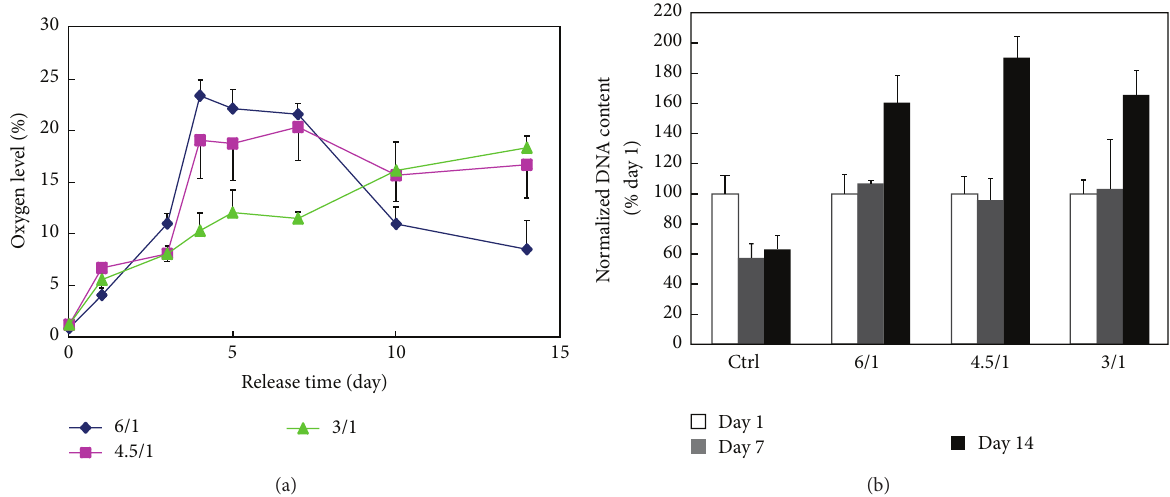
Figure 4: (a) Oxygen release kinetics of the H 2 O 2 -releasing microspheres with different H 2 O 2 /VP ratio; (b) dsDNA content of live CDCs encapsulated in hydrogels with or without oxygen release. The higher dsDNA content represents higher live cell number. Cells were cultured under 1% oxygen condition. Hydrogels with oxygen release had microspheres with H 2 O 2 /VP ratio of 6/1, 4.5/1, and 3/1, respectively. This figure is adopted from